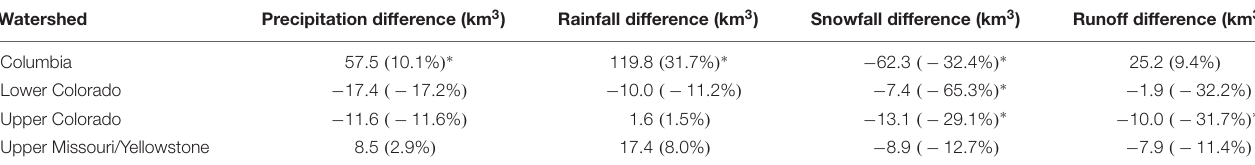
TABLE 1 | Change in volume of hydroclimate variables between end-century and historic average values for western watersheds.